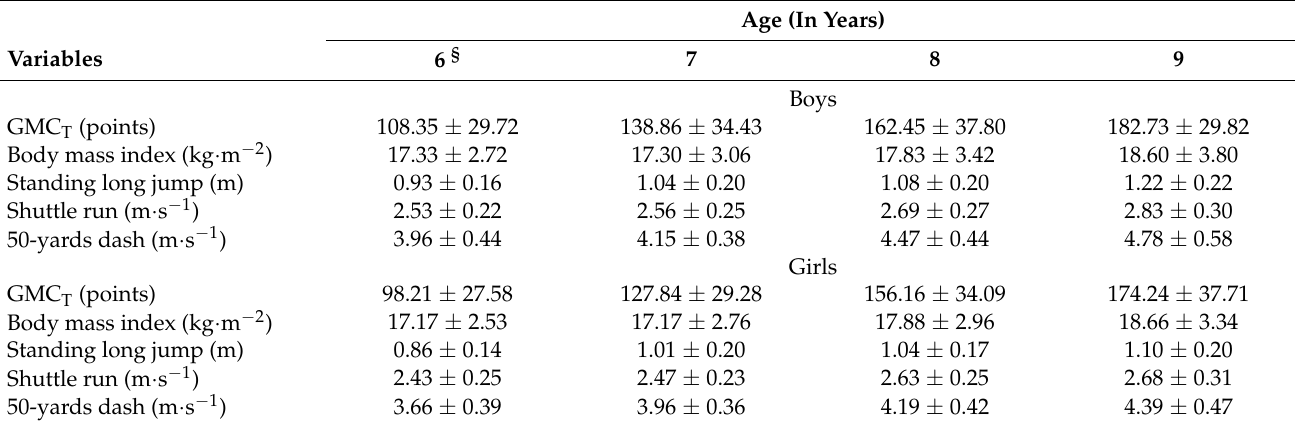
Table 1. Means ± standard deviations of all variables in both boys and girls across age.